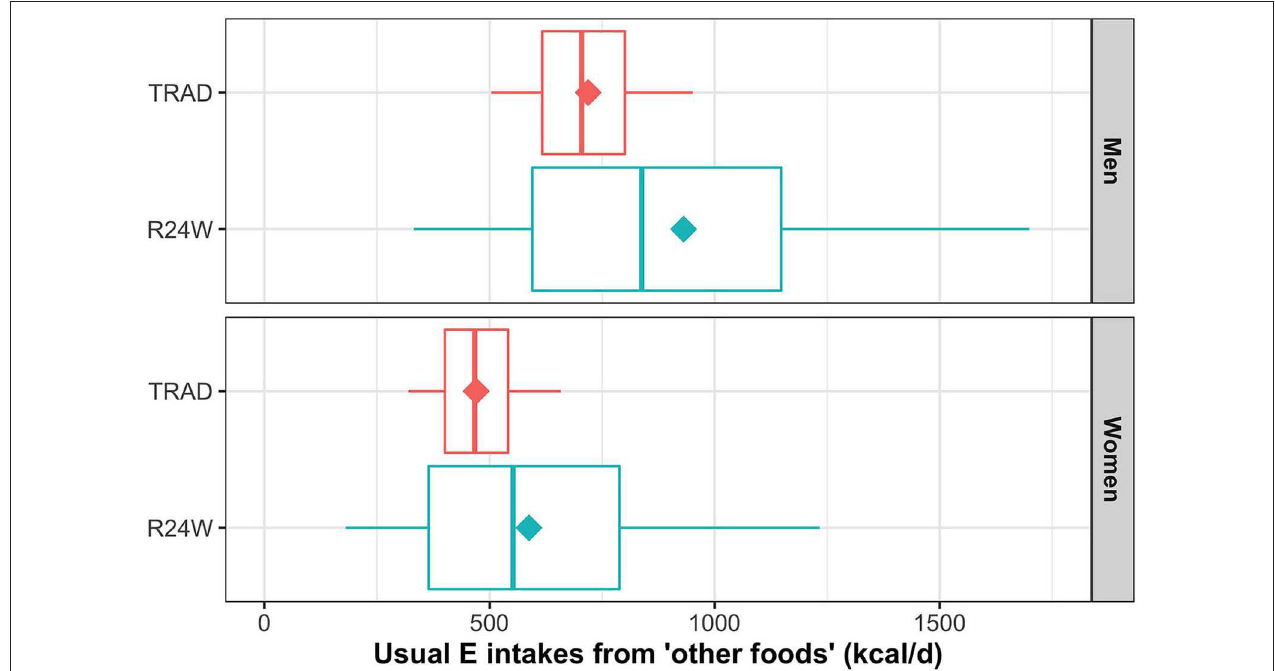
FIGURE 2 | Box-and-whisker plot of energy intakes from “other foods” (kcal) by dietary assessment instrument and sex. The NCI methods 2.1 (amount model) were used to compute usual intake distribution. Boxes represent quantiles 0.25, 0.50, and 0.75. Lower and upper whiskers are respectively quantiles 0.05 and 0.95. Diamonds are mean. Data were adjusted for age, sex, administrative region, education level, body mass index, weekend, and season through the sample balancing process using sex-specific sampling weights. E, energy.